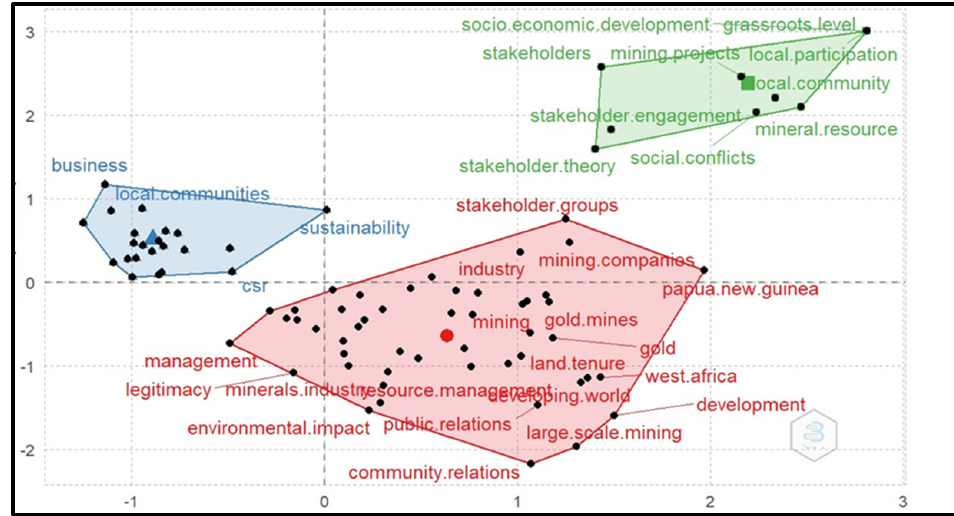
Figure 7. Conceptual Structure.